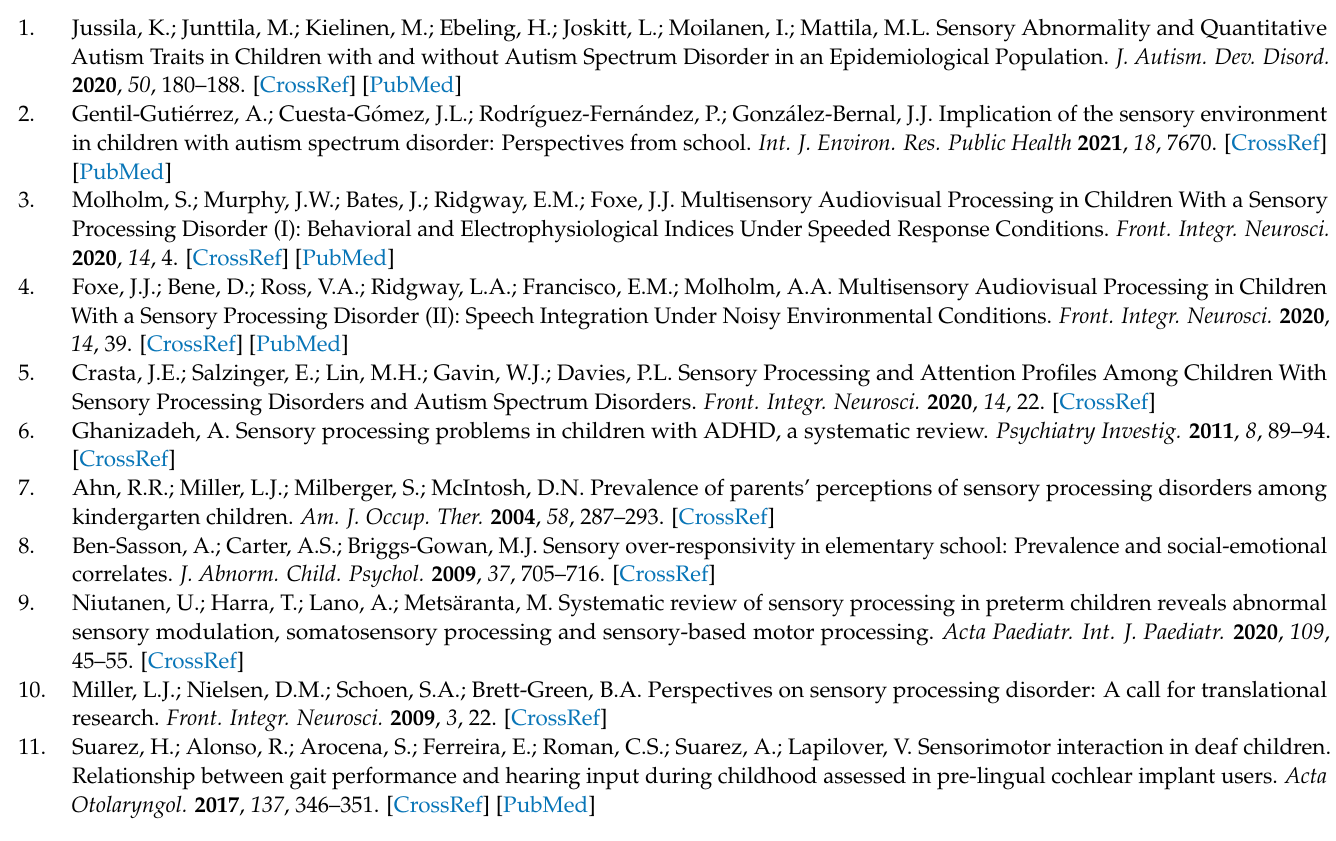
Figure S3: The vertical ground reaction force (GRF) in the left foot and right foot during walking in the SPD children and healthy controls; Figure S4: The regional plantar force in the left foot and right foot during walking in the SPD children and healthy